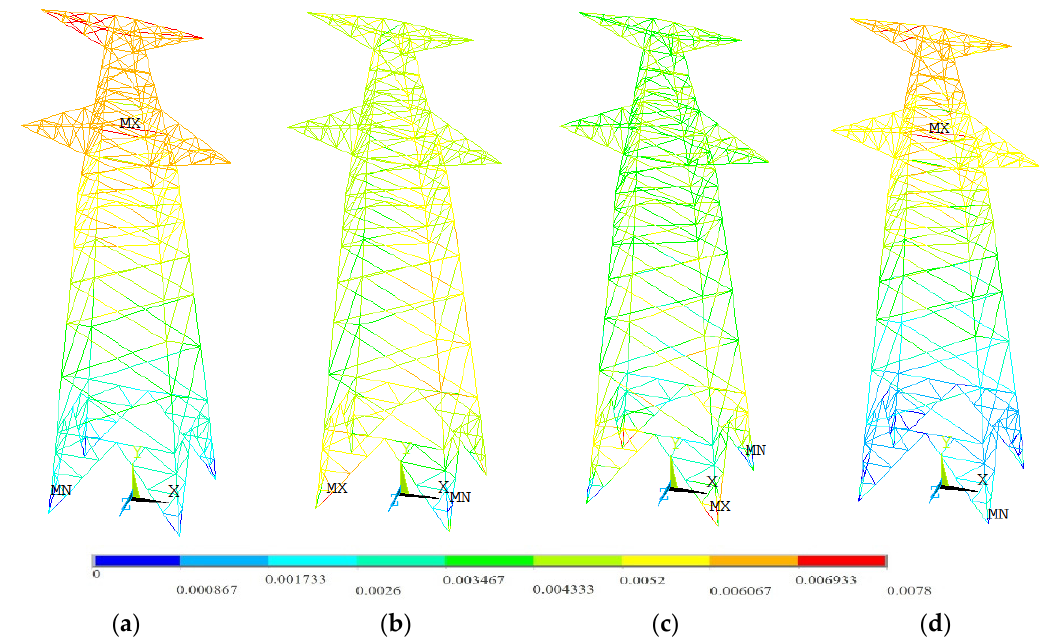
Figure 5. Rotation of the transmission tower in the first order vibration mode; ( a – c ) are the results in the X, Y and Z directions, respectively, and ( d ) is the sum vector result.